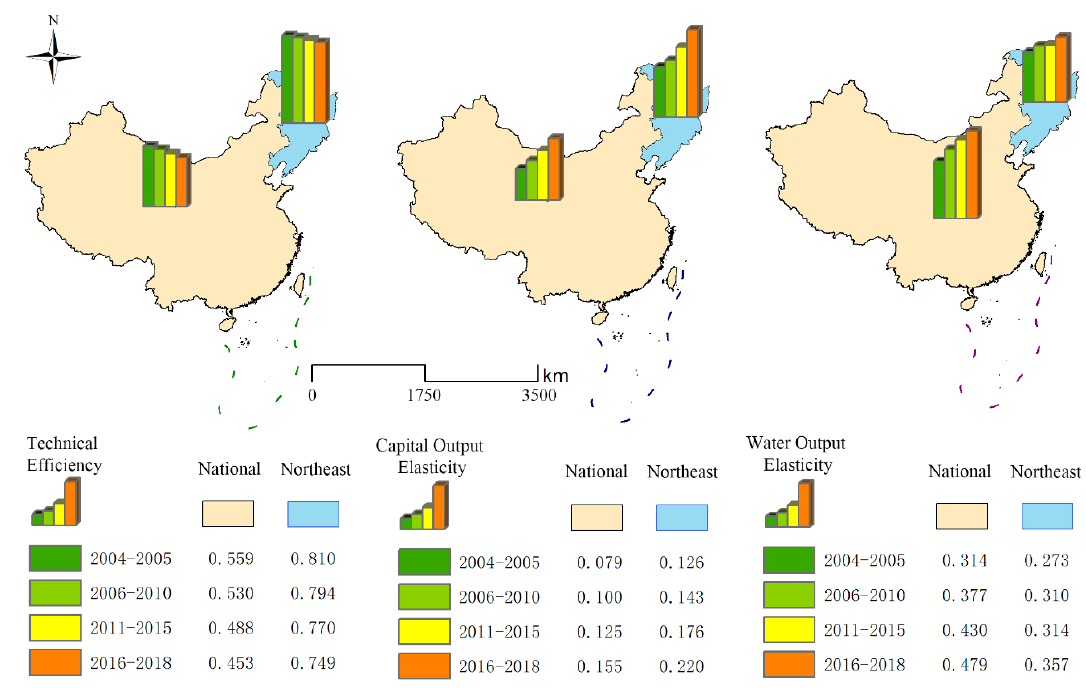
Figure 8. Comparison of technical efficiency and capital and water output elasticity between the nation and Northeast in four different time periods.